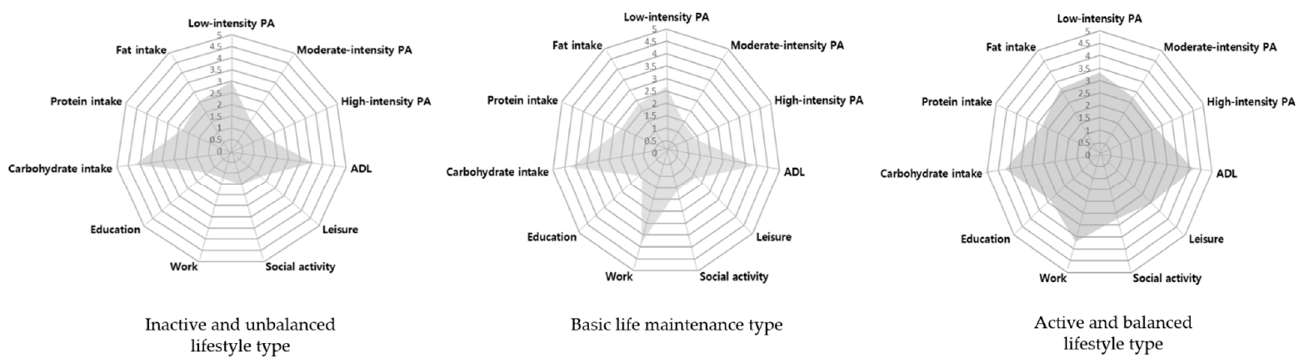
Figure 2. The tendencies of three distinctive lifestyle types. PA: Physical activity; ADL: Activity of Daily Livings. The “inactive and unbalanced lifestyle type” profile consisted of 36.4% (N = 207) of